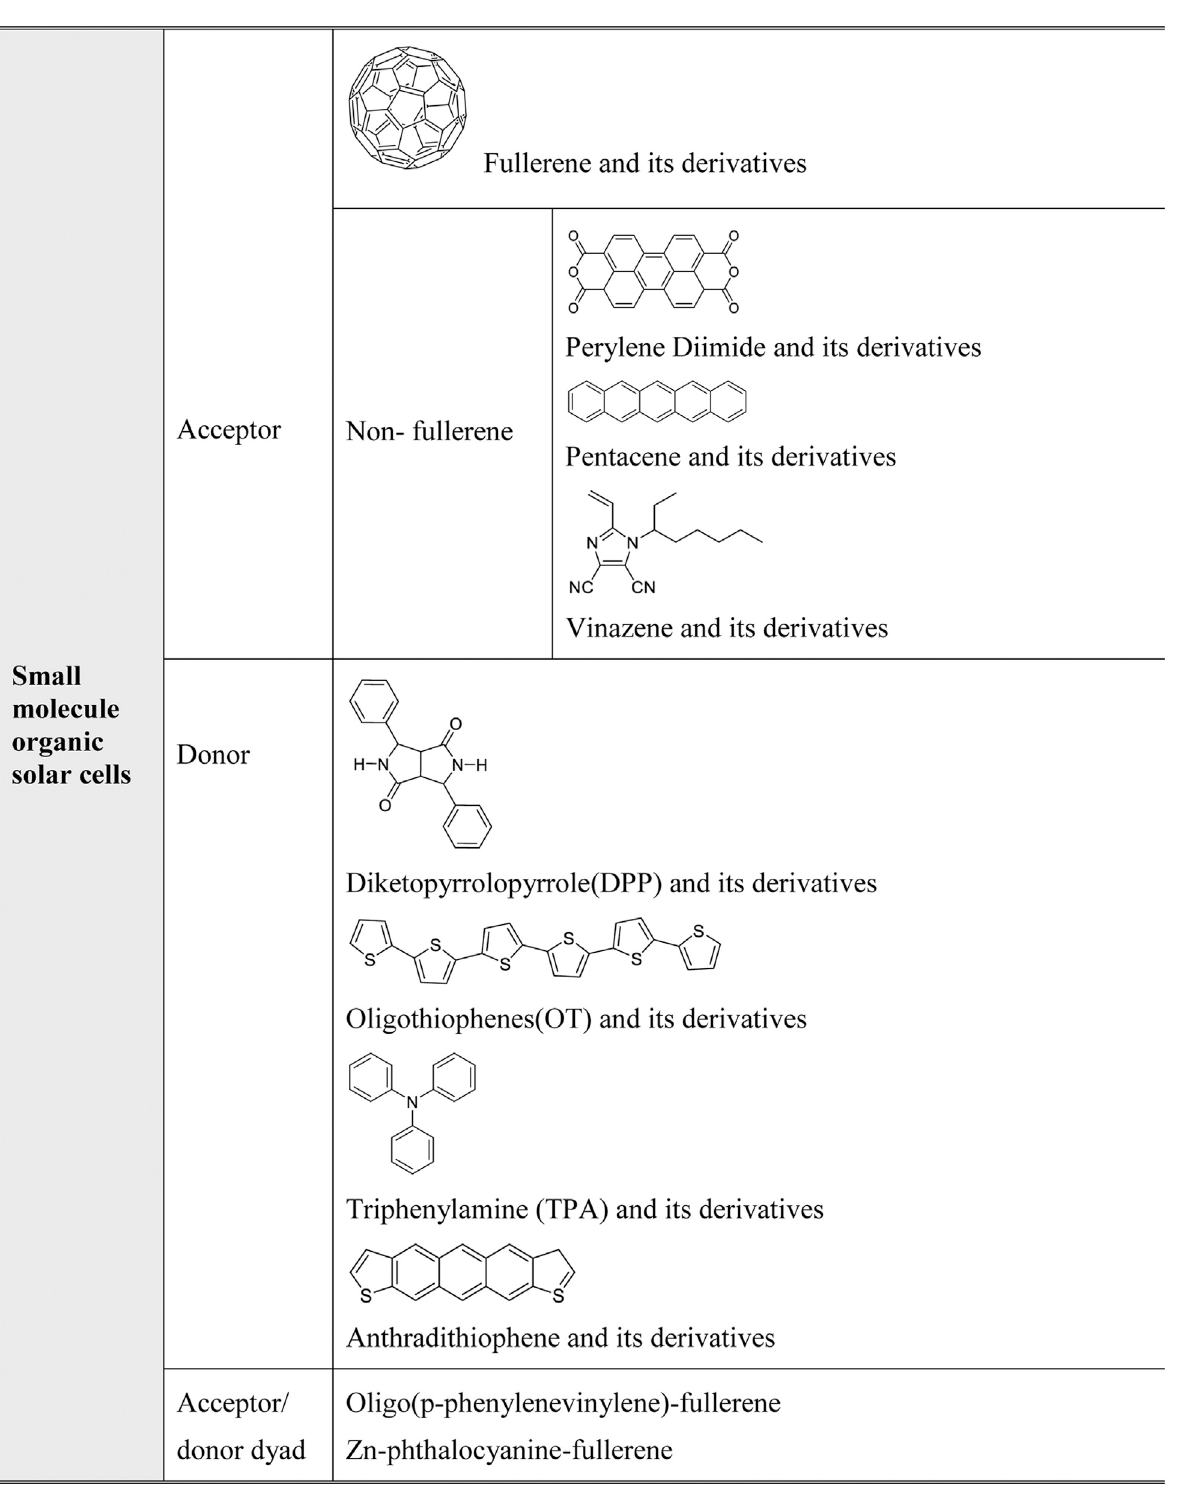
TABLE 2 | Small molecules used in organic solar cells.